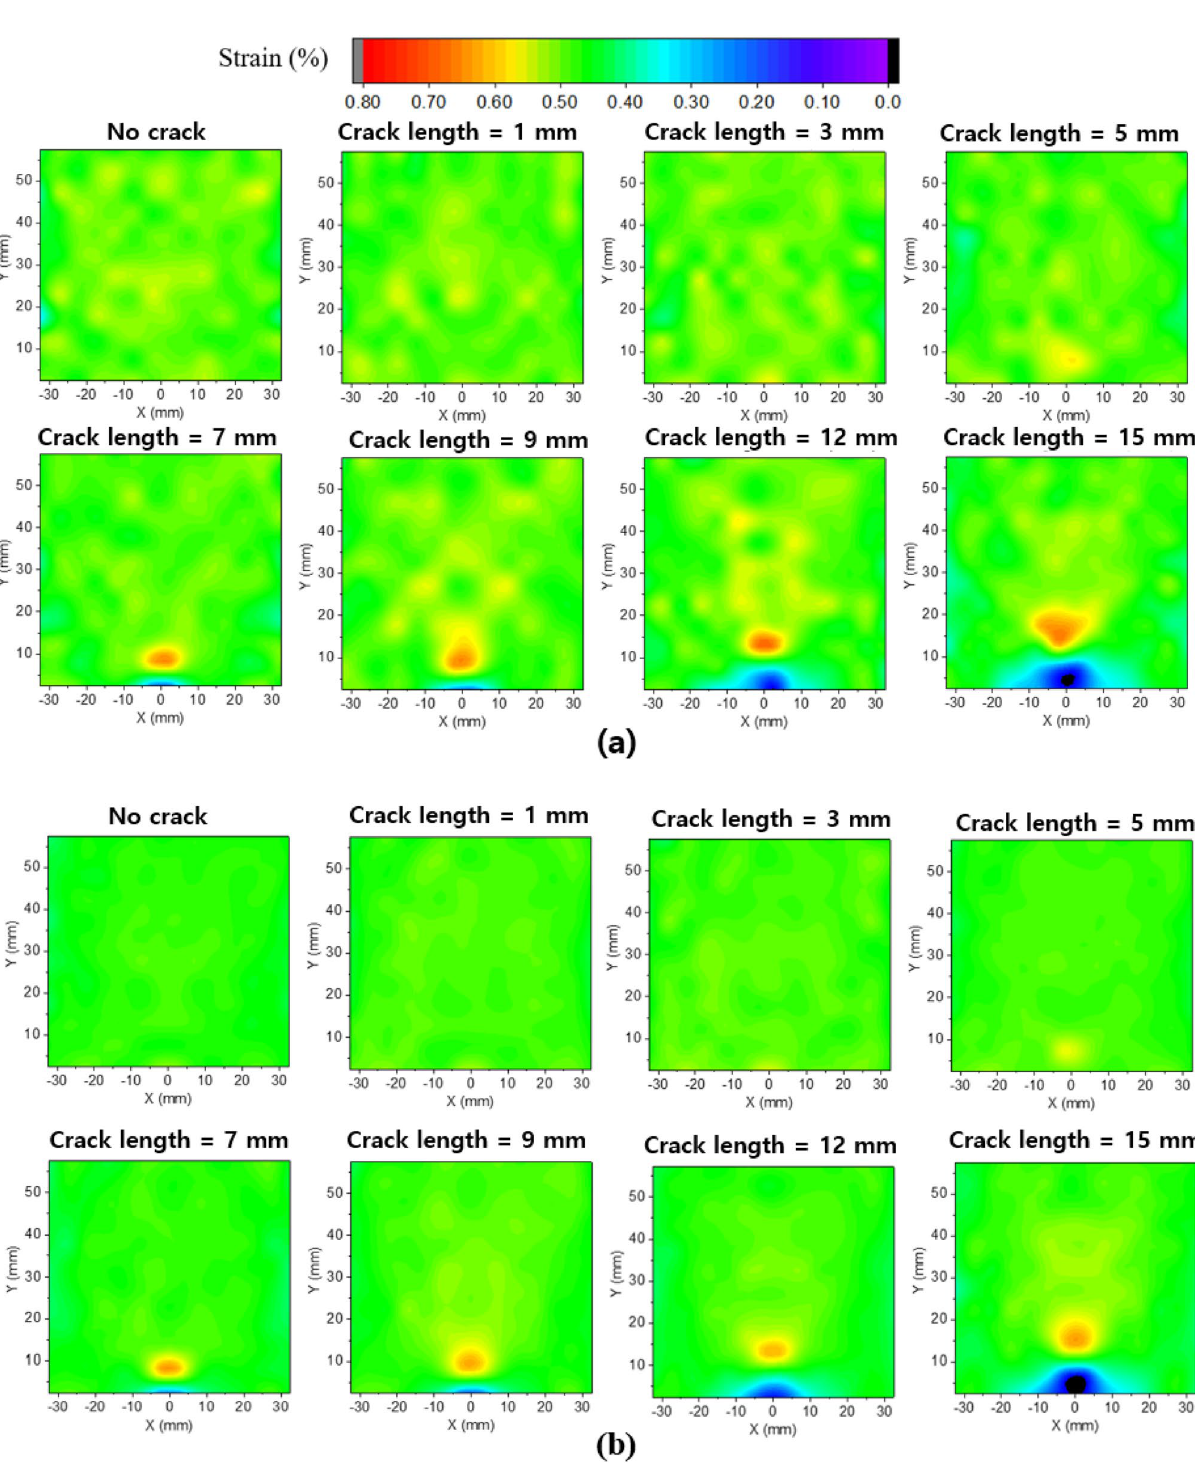
Figure 6. Comparison of actual and predicted strain fields ( a ) actual strain field measured with DIC device, ( b ) strain field predicted by the DNN